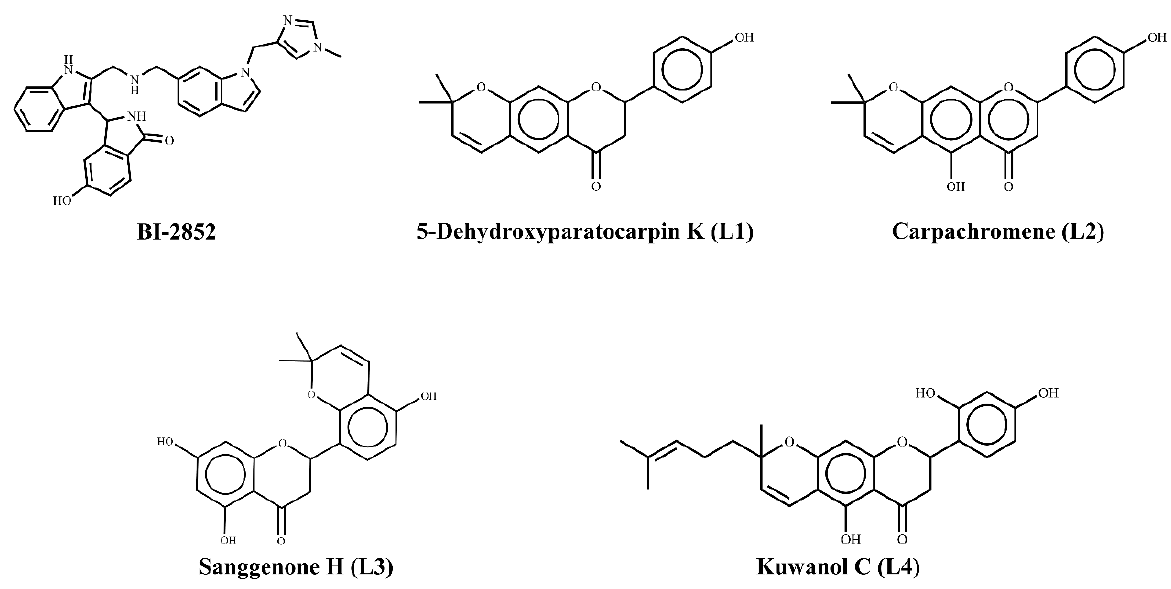
Figure 9. 2D structures of BI ‐ 2852 and top 4 lead flavonoids.